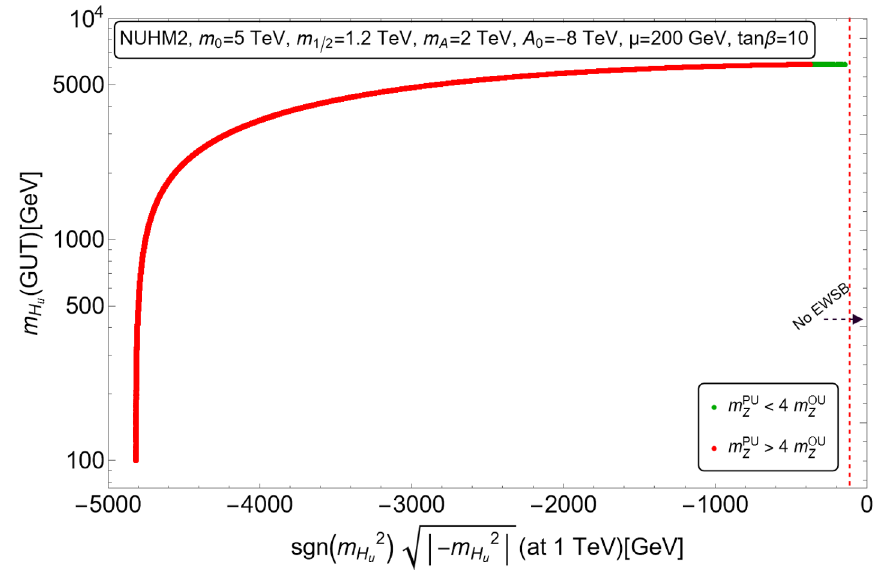
q ( weak ) ≡ sign ( m 2 ) − m 2 ( weak ) vs. m H ( m GUT ) The green points H u H u u u < 4 m OU so that the atomic principle is weak weak > 4 m OU weak weak